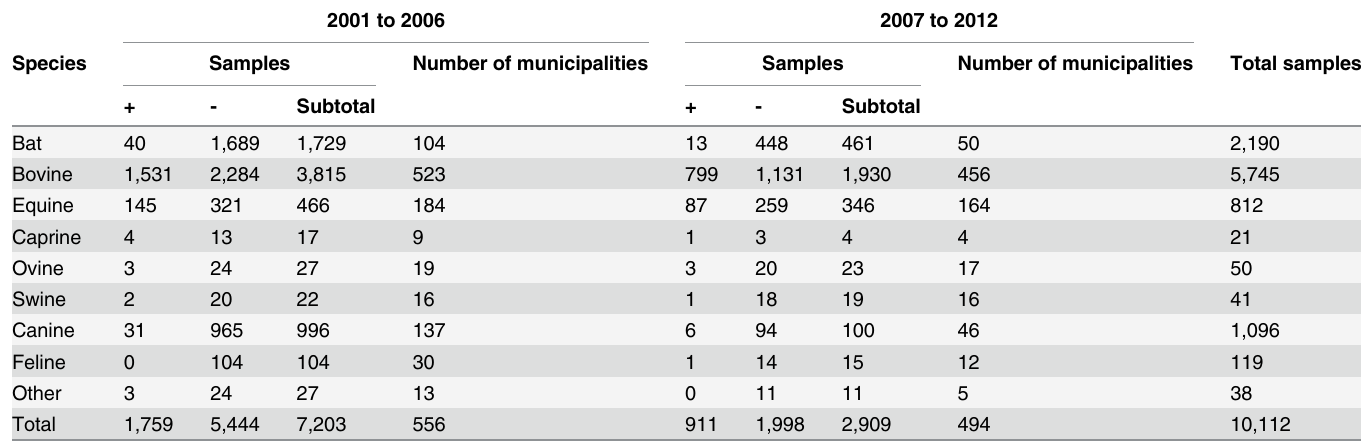
Table 1. Diagnoses of rabies for each species affected, according to data provided by the animal rabies passive surveillance data in Minas Gerais, Brazil, from 2001 to 2012. 2001 to